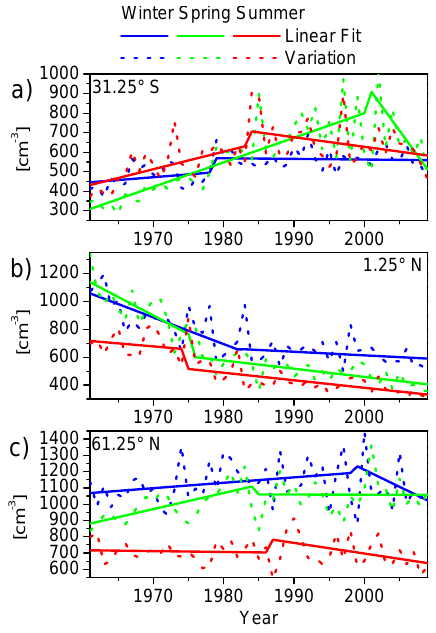
Figure 16. Three arbitrary examples of changing trend calculated by the program SSTS. Note different